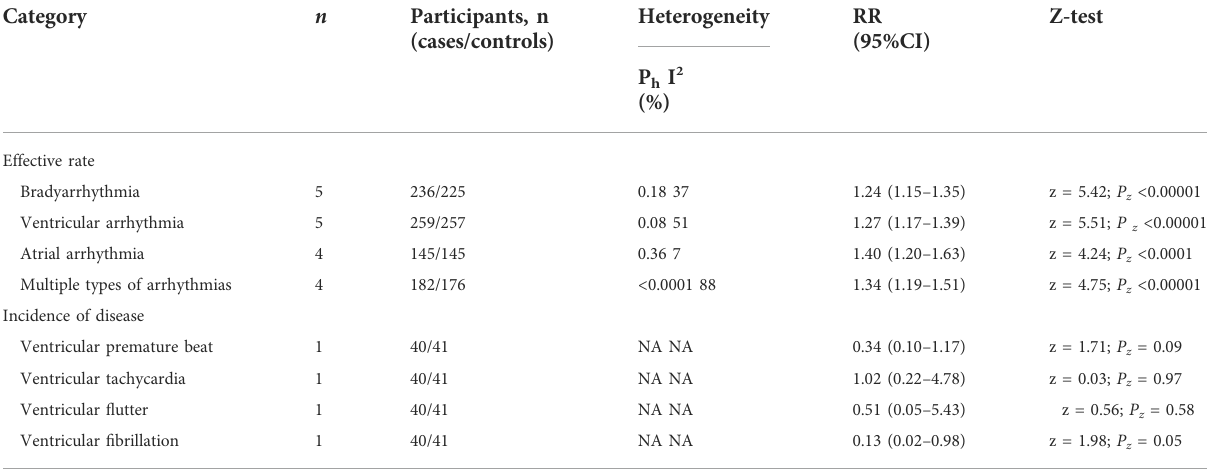
TABLE 1 Meta-analysis of arrhythmia patients ’ treatment with